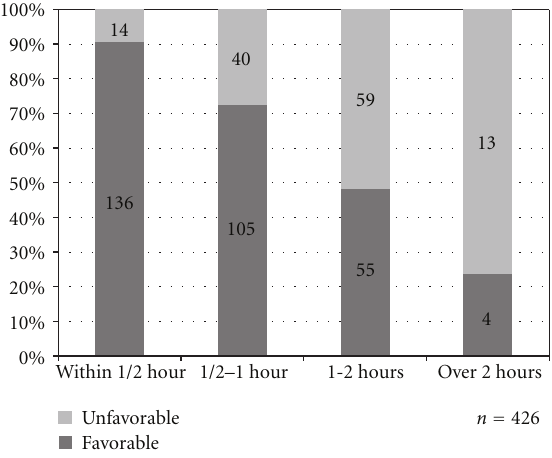
Figure 4: Patient response towards waiting time on colonoscopy day across the di ff erent duration of waiting time on colonoscopy day ( P < 0 . 001 across each of the categories of waiting